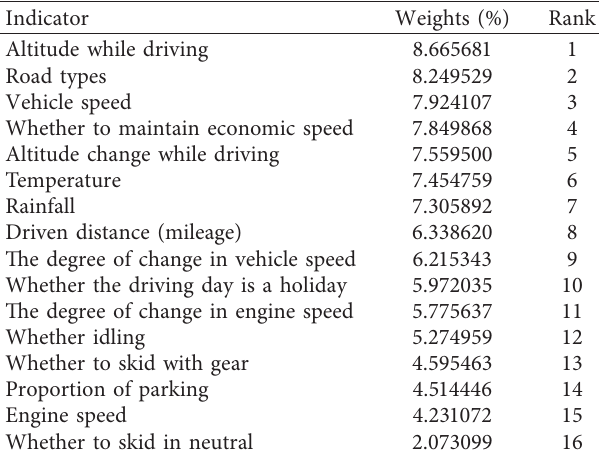
Table 5: Factor importance ranking of driver’s awareness